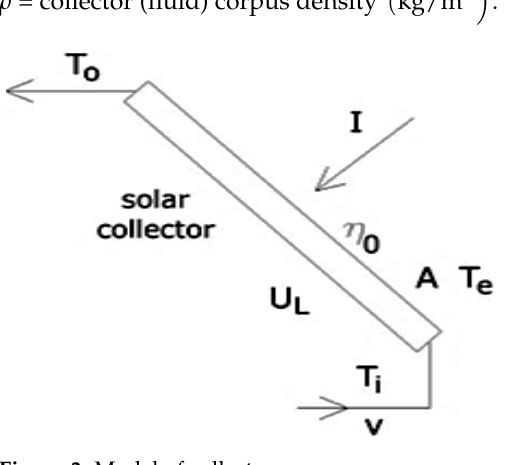
Figure 3. Model of